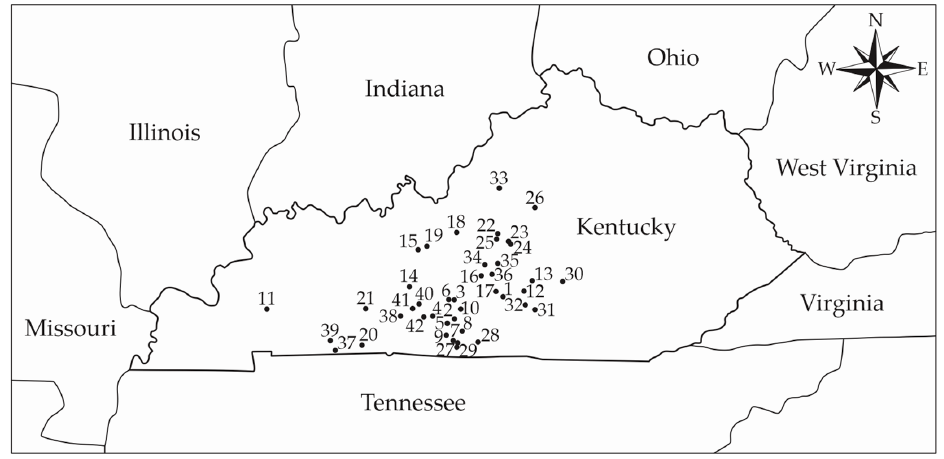
Figure 1. Distribution of the assessed CBP barns in the state of Kentucky (USA). 1 to 42—number of the assessed CBP barn